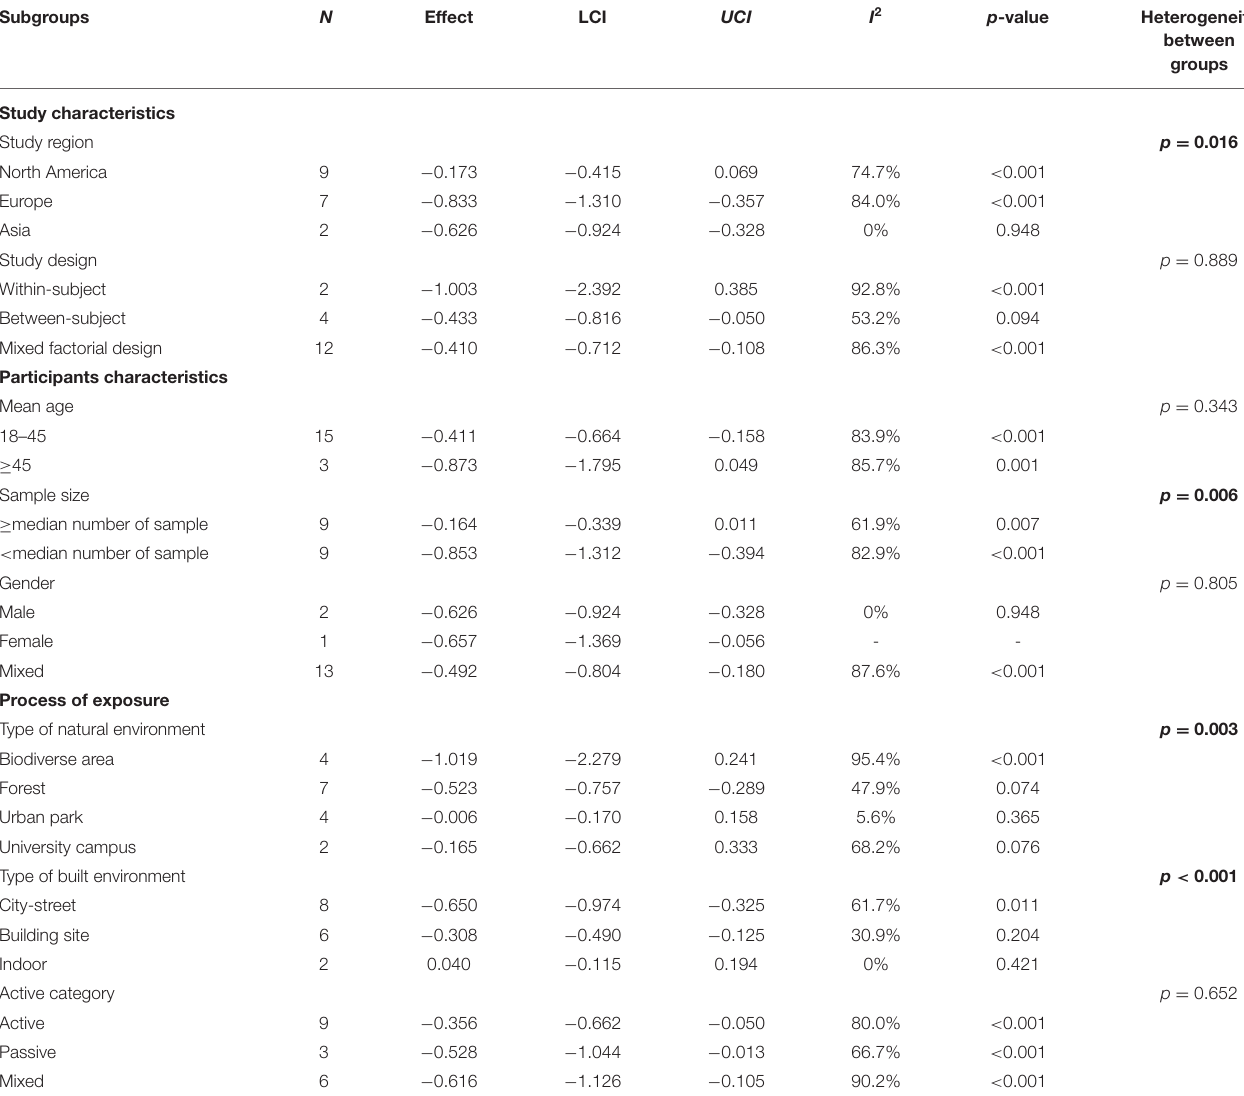
TABLE 3 | Summary of subgroup analysis of negative affect studies ( n = 18) conducted by study characteristics, participants characteristics, and process of exposure. Subgroups Heterogeneity